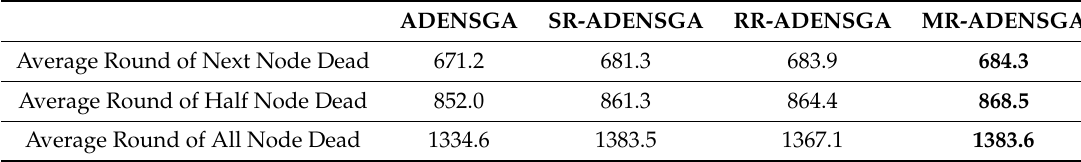
Table 3. Average Lifetimes for Different